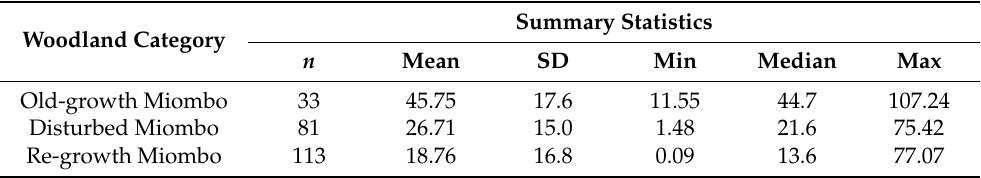
Table 1. Aboveground carbon stocks in miombo